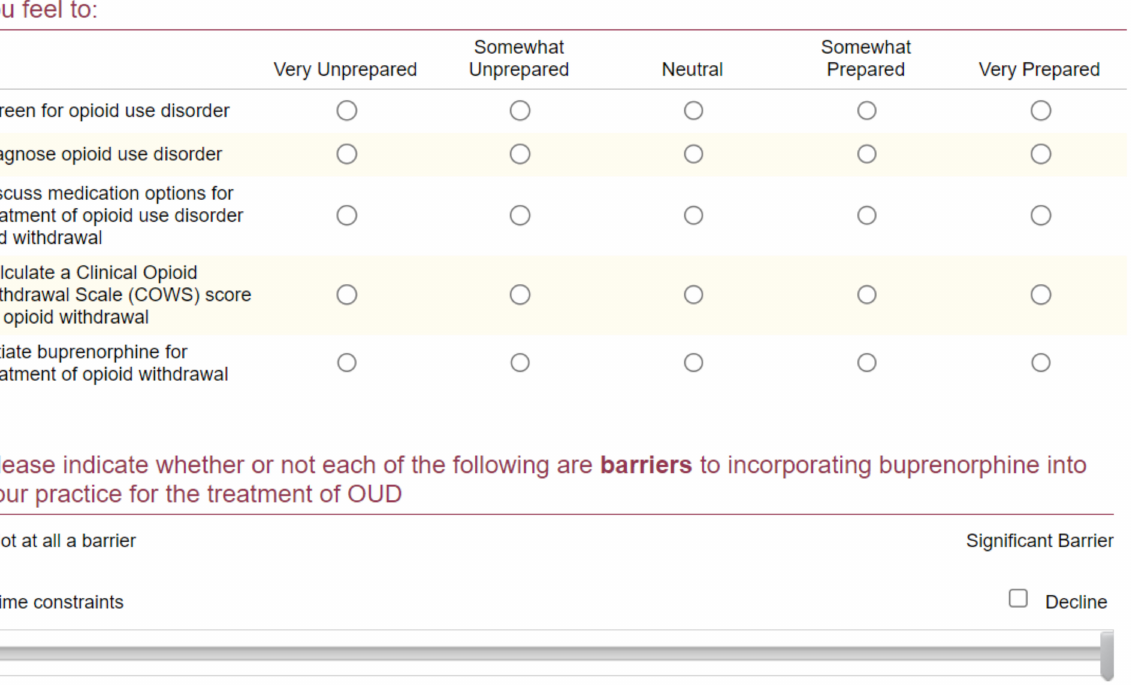
Figure A1. Sample of electronic survey questions and response